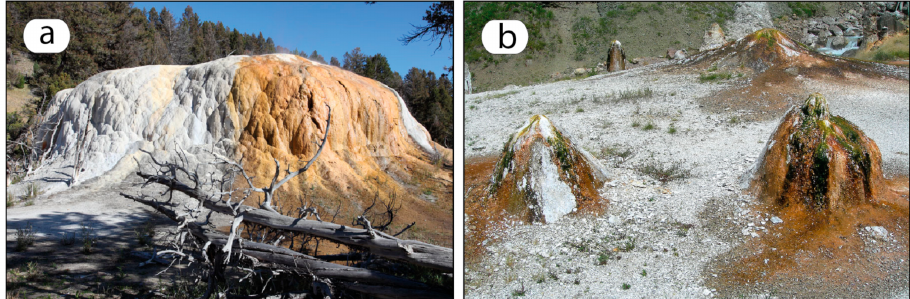
Figure 9. Photographs illustrating coalescing ( a ) and isolated mound-type deposits from the Yellow- stone National Park (United States) ( b